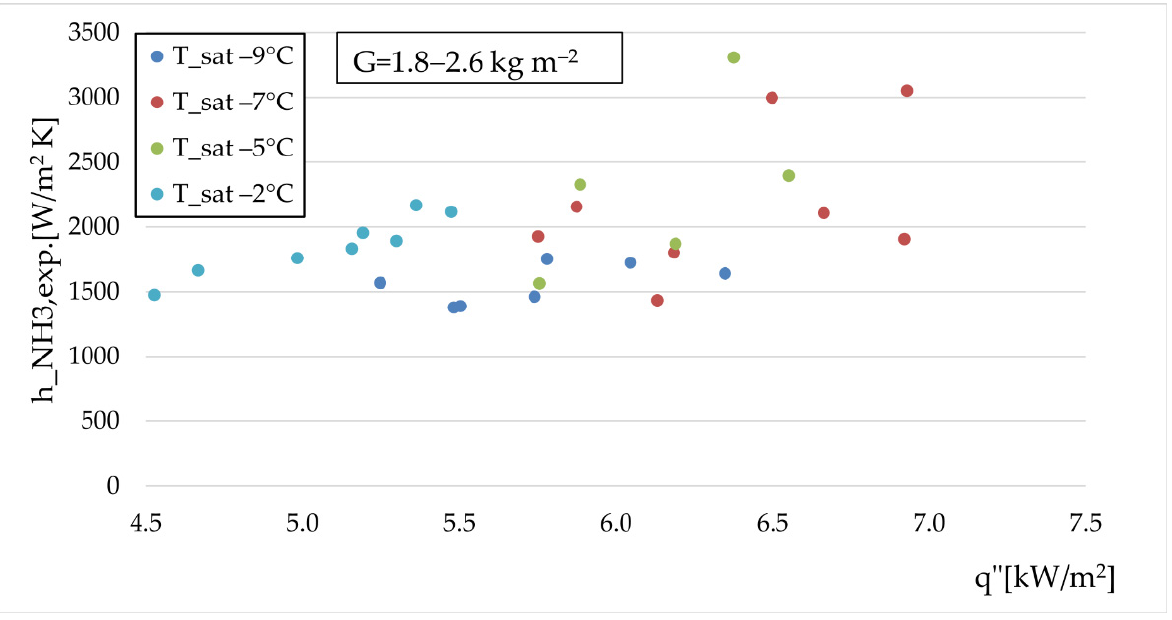
Figure 8. Experimental heat transfer coefficient vs. mass flux. The experimental value of the ammonia boiling heat transfer coefficient vs. heat flux at various temperatures is presented in Figure 9.